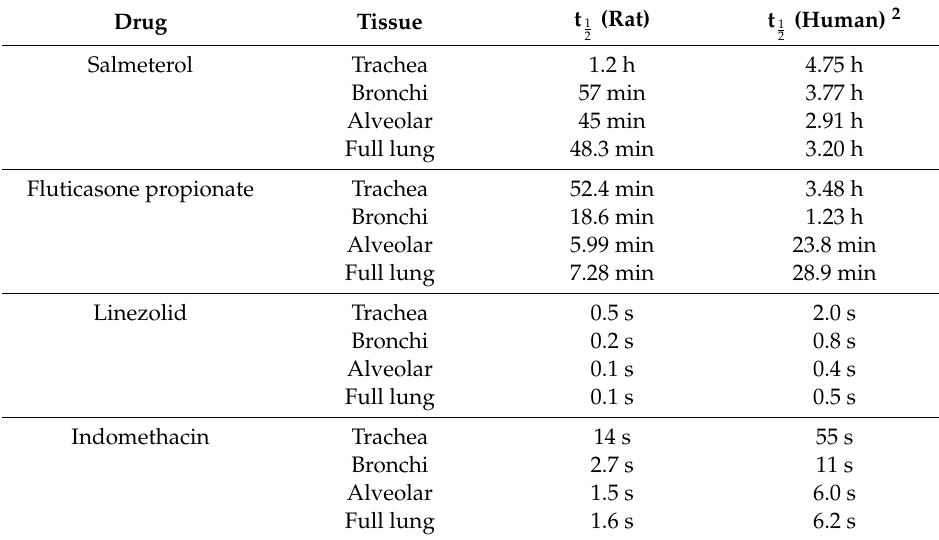
) 1 derived from model 2